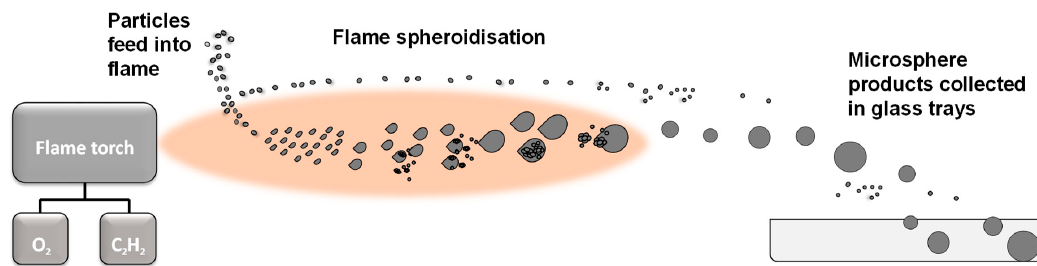
Figure 10. Schematic representation of the single-stage, fl ame spheroidisation process. The processed materials were collected using glass trays, placed a short distance away from the thermal spray gun, and stored in glass vials for characterisation. Parameters to evaluate the e ff ects of Fe 3 O 4 precursor to CaCO 3 porogen mass ratios (3:1, 1:1 or 1:3) and oxy-acetylene gas fl ow se tt ings (O 2 /C 2 H 2 ; 2:2, 2.5:2.5 or 3:3) on the resultant products are summarised in Tables 8 and 9, respectively. Table 8. Parameters to evaluate the e ff ects of Fe 3 O 4 :CaCO 3 mass ratio.